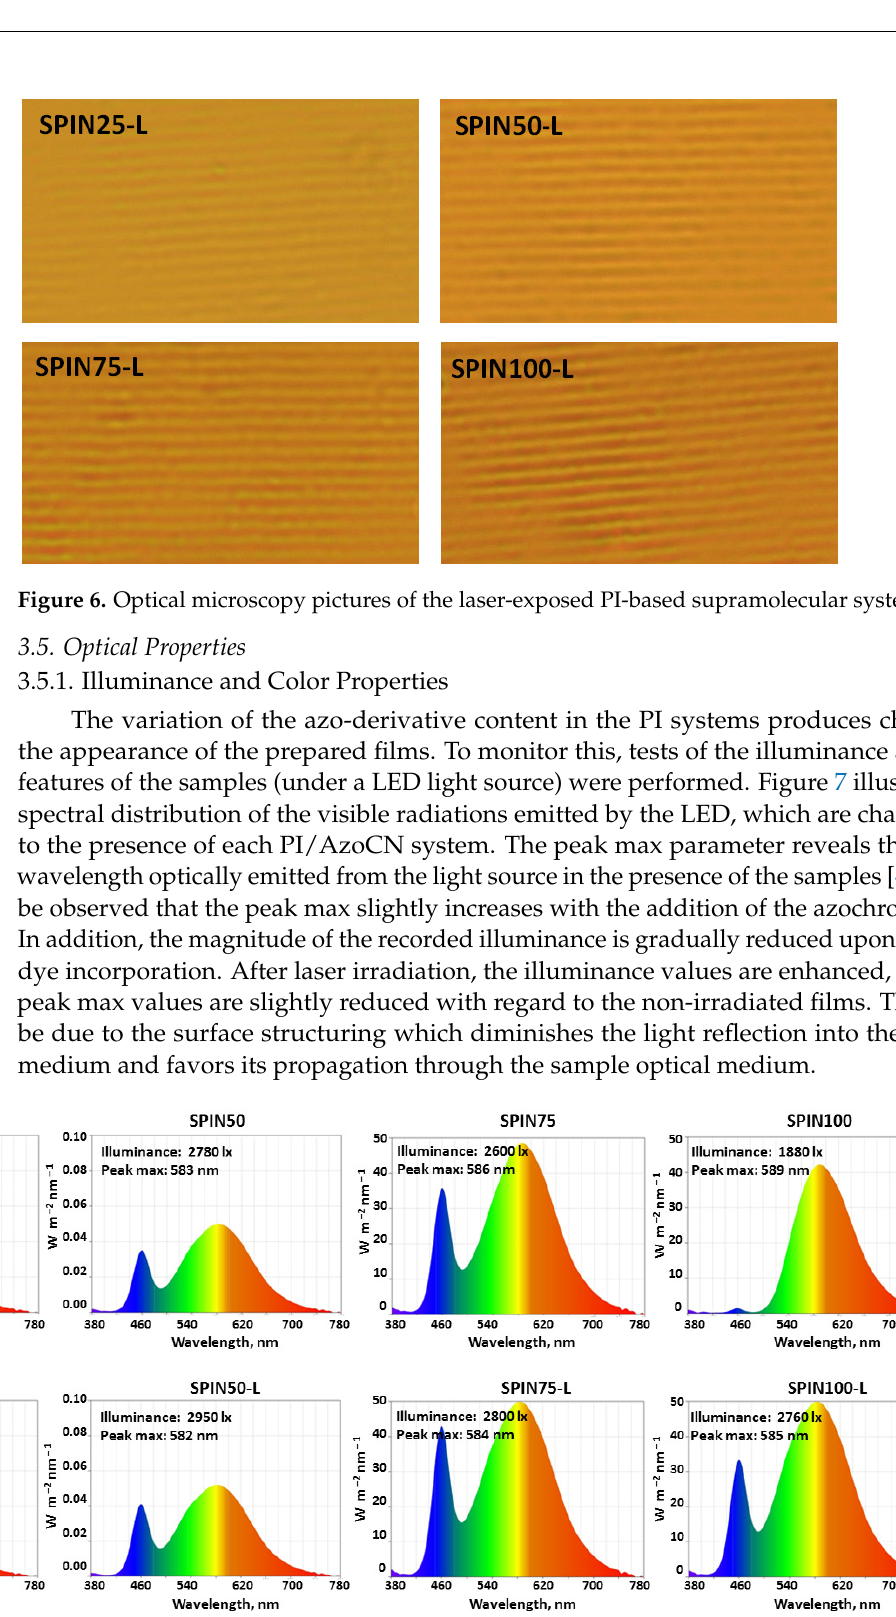
Figure 7. Spectral distribution of the visible radiations emitted by the LED recorded in the presence of the PI-based supramolecular systems before and after laser